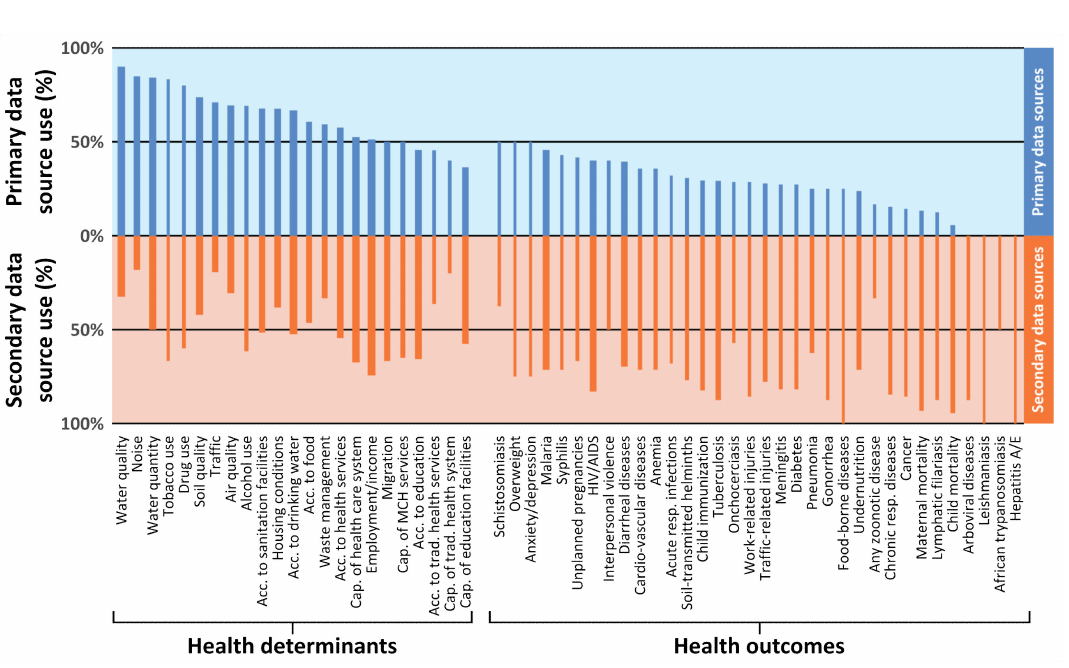
Figure 4. Data sources used for assessing health aspects in impact assessment reports. The height of the bars indicate the percentage of reports using any primary (blue bars) and any secondary (red bars) data source for the di ff erent health aspects. Bar widths indicate the number of reports considering the specific health aspect (used as denominator for determining the bar height of the respective aspect). Acc. = access; Cap. = capacity; MCH = maternal and child health; resp. = respiratory; trad. =